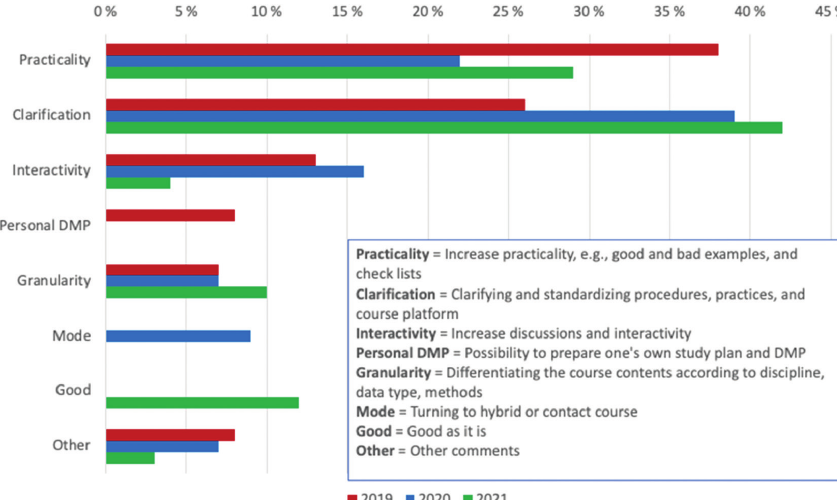
Fig. 5: Seven top sub-categories based on the feedback comments given in the main category “How would you suggest the module